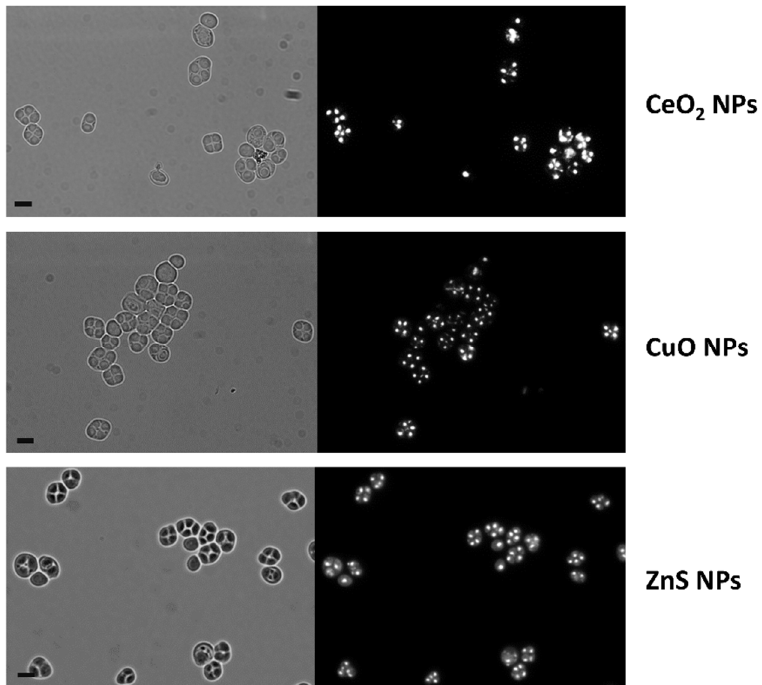
Figure 4. Effect of metal-based NPs on sporulation process. Yeast cells were grown in sporulation medium at 28 ◦ C for 72 h in the presence of high doses of CeO 2 NPs (20 mg L − 1 ), CuO NPs (100 mg L − 1 ), and ZnS QDs (100 mg L − 1 ). Yeast cells were then stained with DAPI and analyzed using fluorescence microscopy. Representative images are shown. Scale bars, 5 μ m.